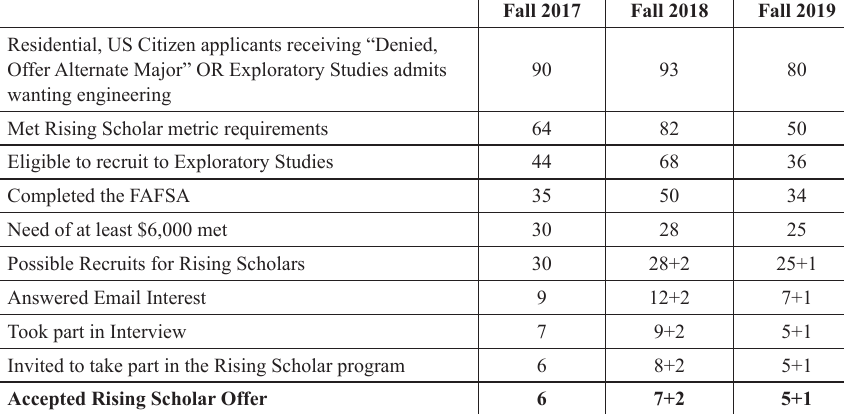
Table 7. Summary chart of the yearly selection processes used to select qualified